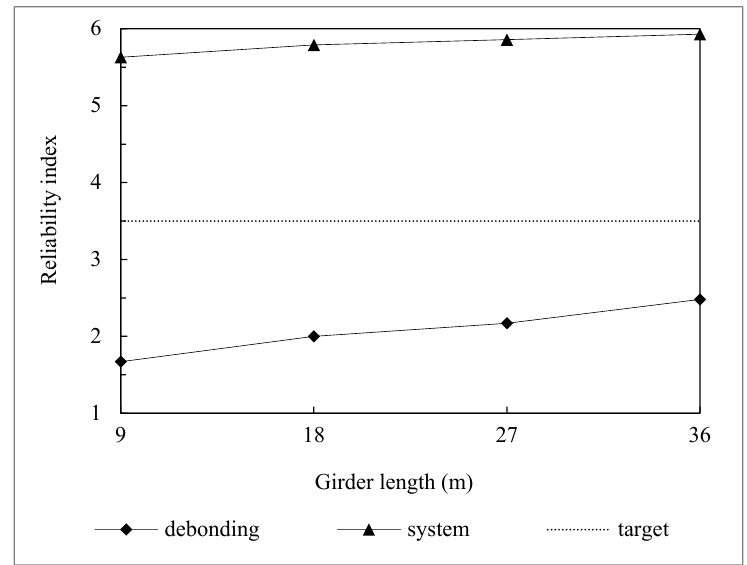
Figure 7. Reliability indices of specimens using Sika S512.